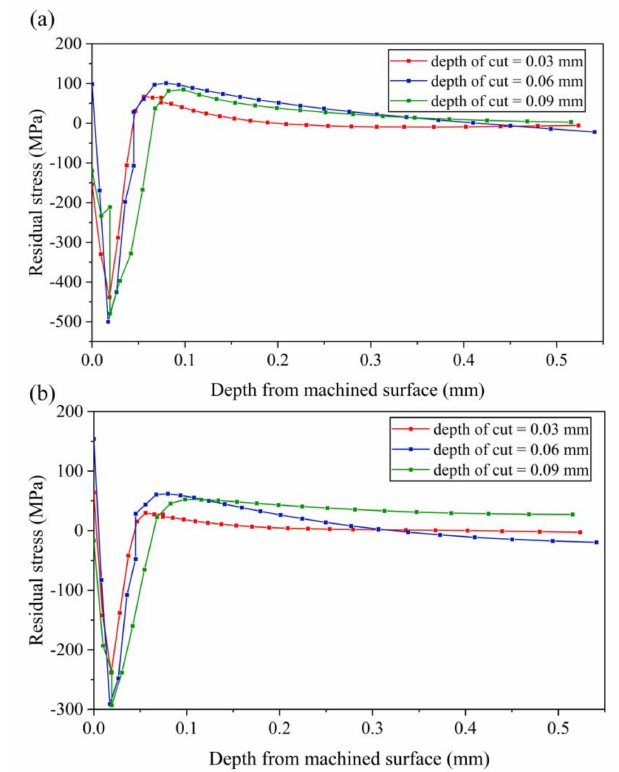
Figure 17. Results of residual stress with various cutting depths ( a ) stress-xx ( b )